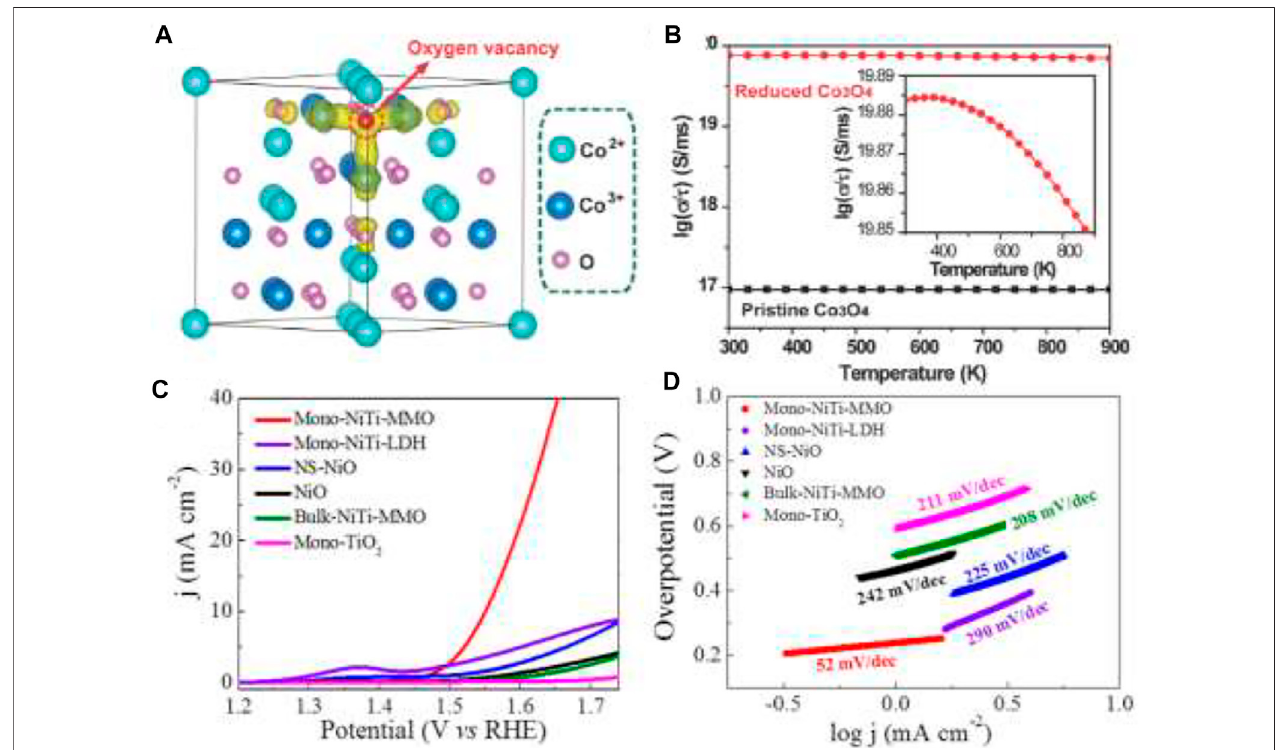
FIGURE 7 | (A) Partial charge density of the reduced Co 3 O 4 . The states of Vo 2+ are displayed in yellow. The iso-surface levels are 0.037 e Å − 3 . (B) Calculated conductivity for the reduced Co 3 O 4 and the pristine Co 3 O 4 . Inset: An expansion of the plot of reduced Co 3 O 4 (Wang et al., 2014) OER performance; (C) linear sweep voltammetry (LSV) curves; (D) corresponding Tafel plots (Zhao et al.,